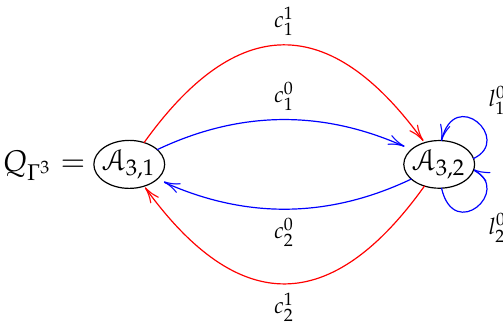
Figure 6. Brauer quiver defined by the Brauer configuration Γ 3 .